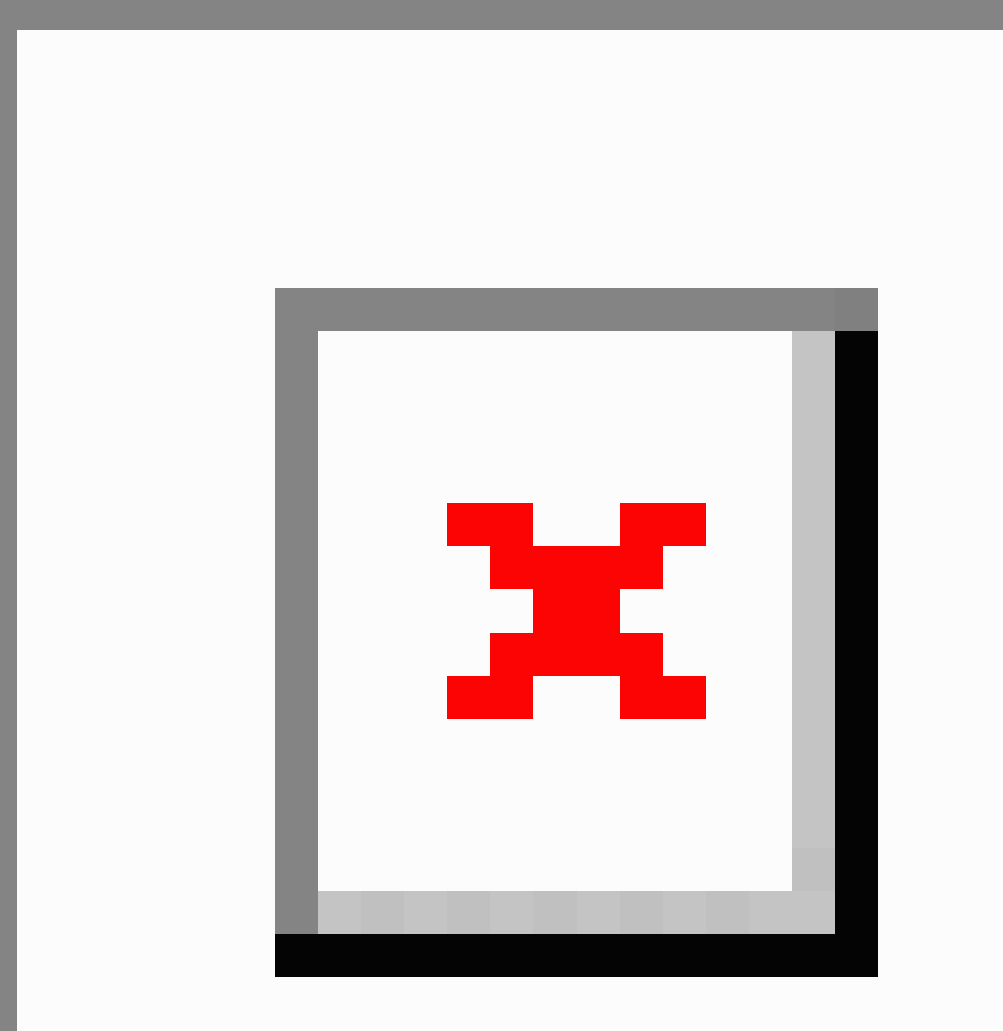
Figure 2. Synchronization of the Schisto Track with the Web server. A New Kind of Simulator (ANKOS); application